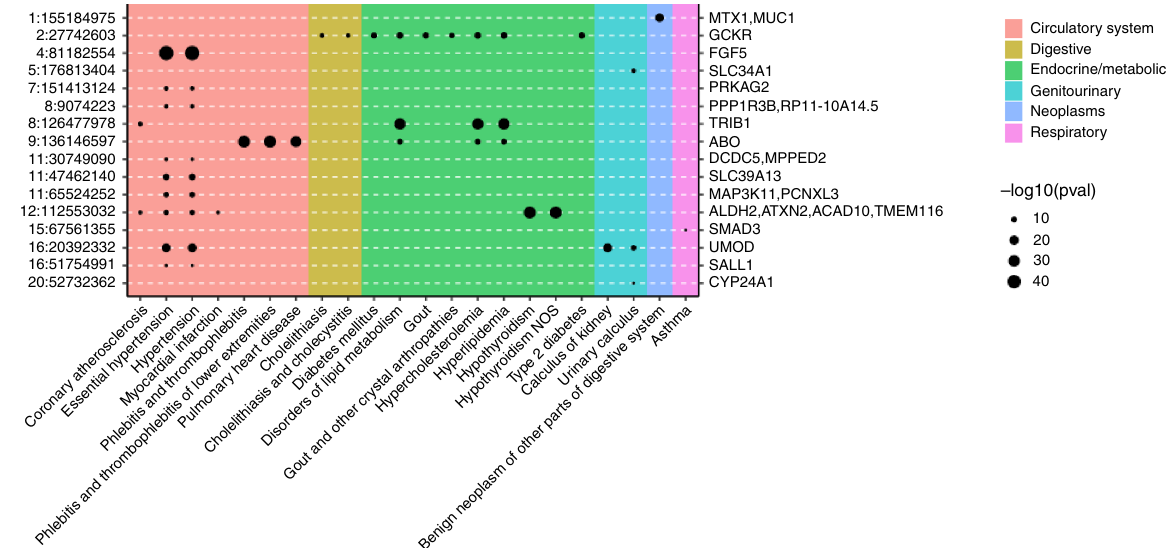
Fig. 2 Pleiotropic associations of eGFR index variants. Index variants, given as chromosome:position on the left axis and prioritized gene on the right, from eGFR meta-analysis showing signi fi cant associations with at least one additional phenotype (16 variants with p -value < 5 × 10 − 8 ) in UK Biobank ( N max = 408,961). 127 variants were tested for association with 1400